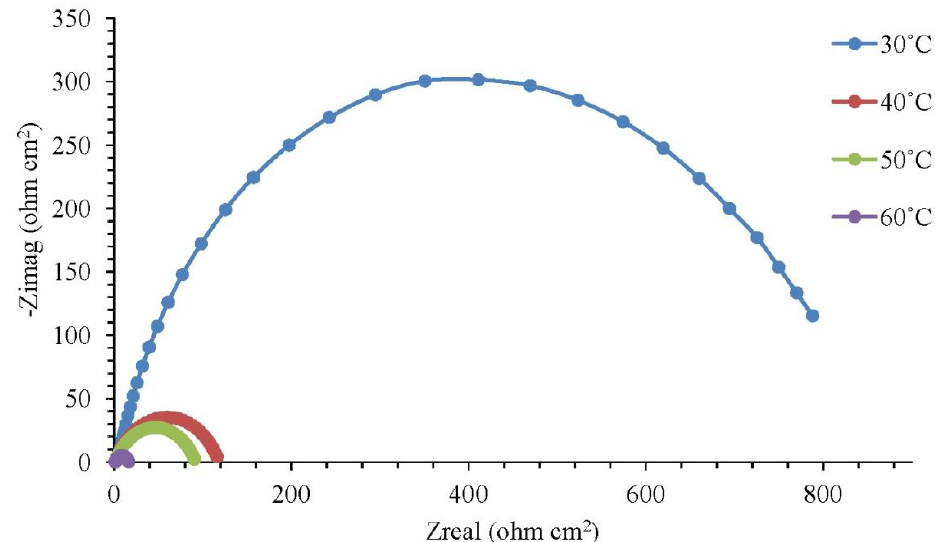
Figure 2. Nyquist plot for mild steel in 1.0 M H inhibitor at different temperatures.